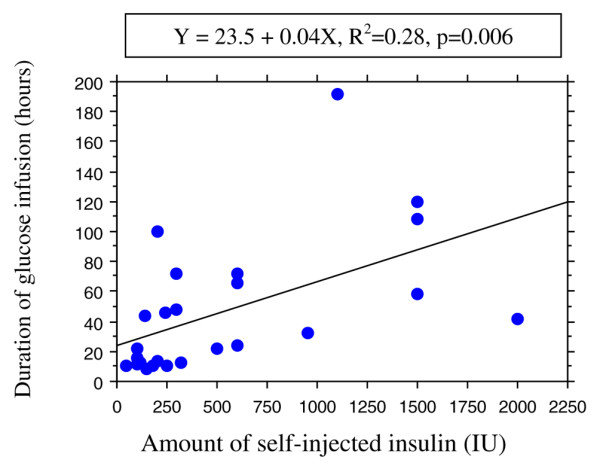
Duration of glucose infusion versus self-injected insulin dose. Shown is the correlation between the duration of glucose infusion and the self-injected insulin dose in 25 cases of insulin self-poisoning.